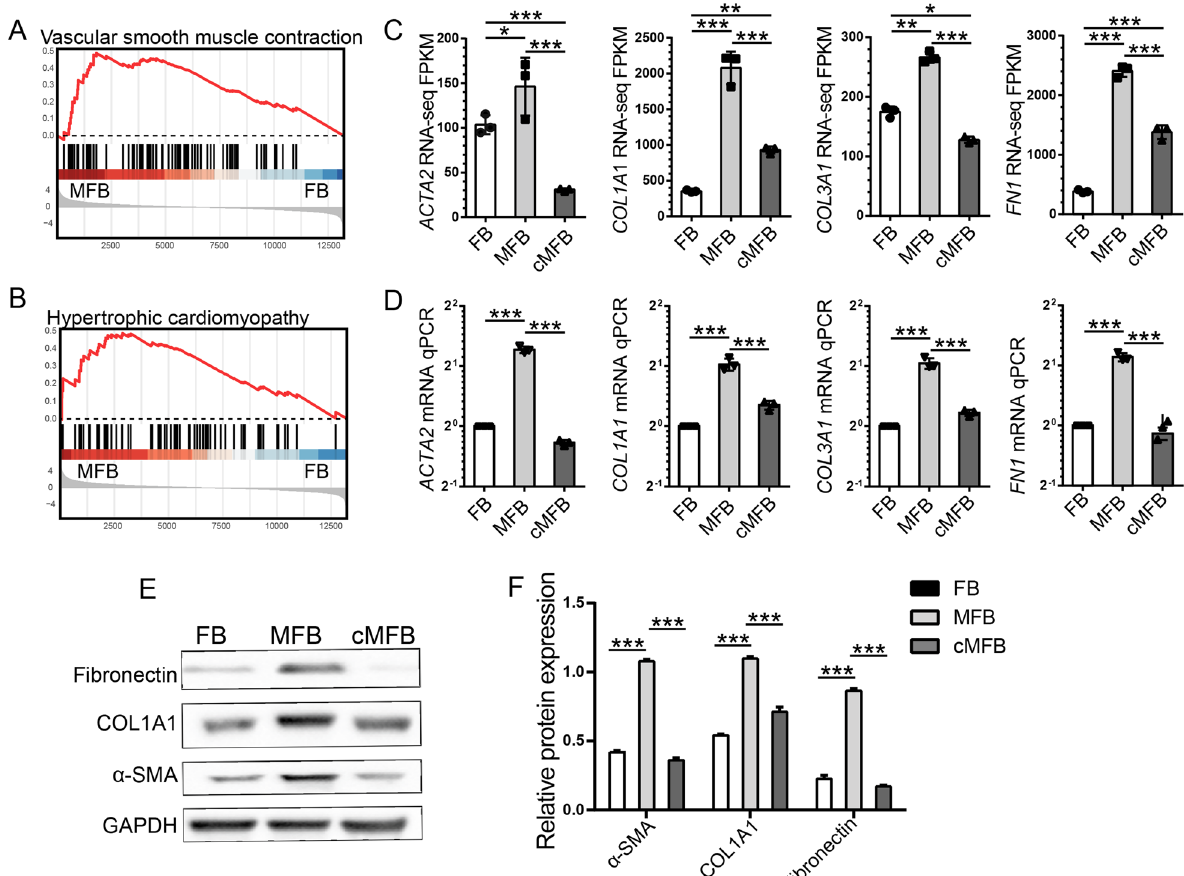
Fig. 4 Co-culturing with uMSC inhibited TGF-β-induced expression of MFB-specific markers. A , B Gene set enrichment analysis (GSEA) indicates activation of vascular smooth muscle contraction and hypertrophy cardiomyopathy functions in TGF-β1-induced MFB. C , D RNA-seq gene expression (FPKM) and qPCR validations for MFB markers, including ACTA2 (encoding for a-SMA), COL1A1 , COL3A1, and FN1 in FB, MFB, and co-cultured MFB samples. E , F Western blot assays on fibronectin, COL1A1, and a-SMA proteins in FB, MFB, and co-cultured MFB samples. FPKM, fragments per kilobase of exon model per million mapped fragments. * < 0.05; **P < 0.01; ***P <